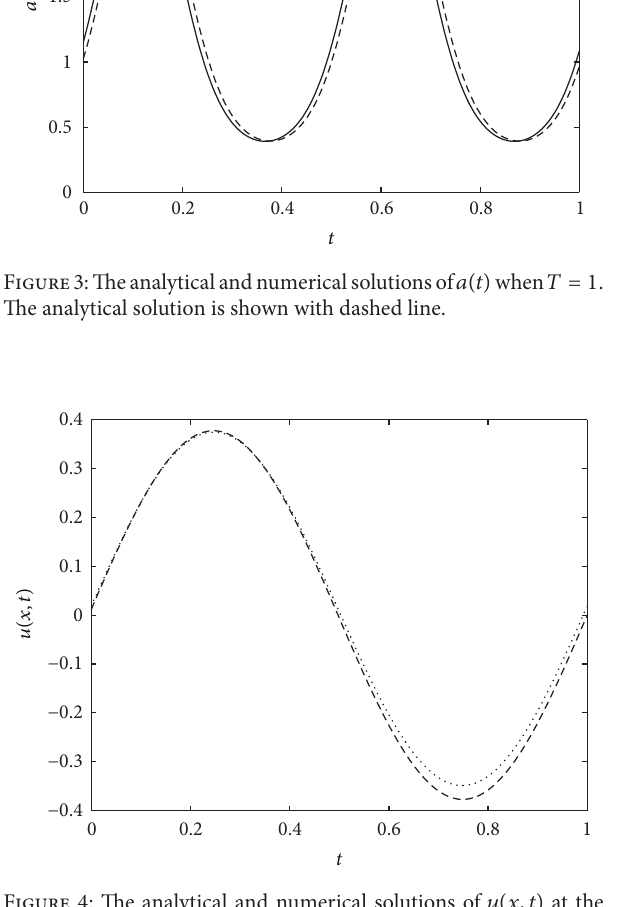
Figure 4: The analytical and numerical solutions of 𝑢(𝑥,𝑡) at the 𝑇 = 1 . The analytical solution is shown with dashed